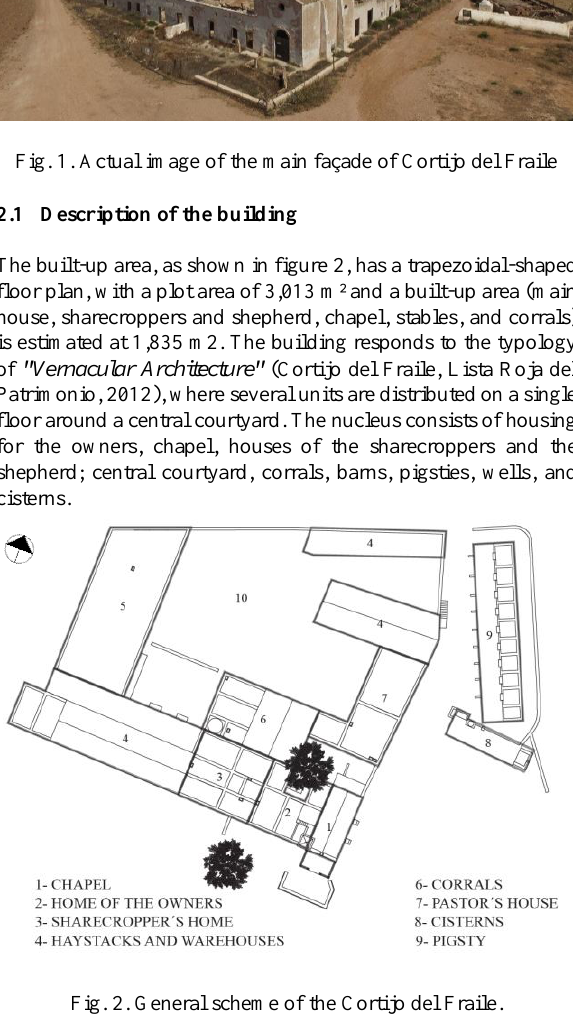
Fig. 2. General scheme of the Cortijo del Fraile.